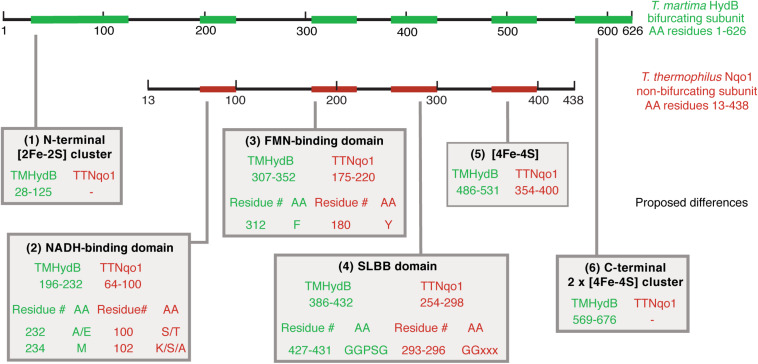
Summary of proposed criteria to differentiate BF enzymes from non-BF NADH-dependent enzymes. An overlay of the T. maritima HydB (green) and the T. thermophilus Nqo1 (red) sequences is shown. The location of the proposed differential criteria that demarcate beta subunits from BF and non-BF NADH-dependent enzymes are numbered at the bottom from (1) to (6) and the relevant region of the sequence is indicated by arrows.